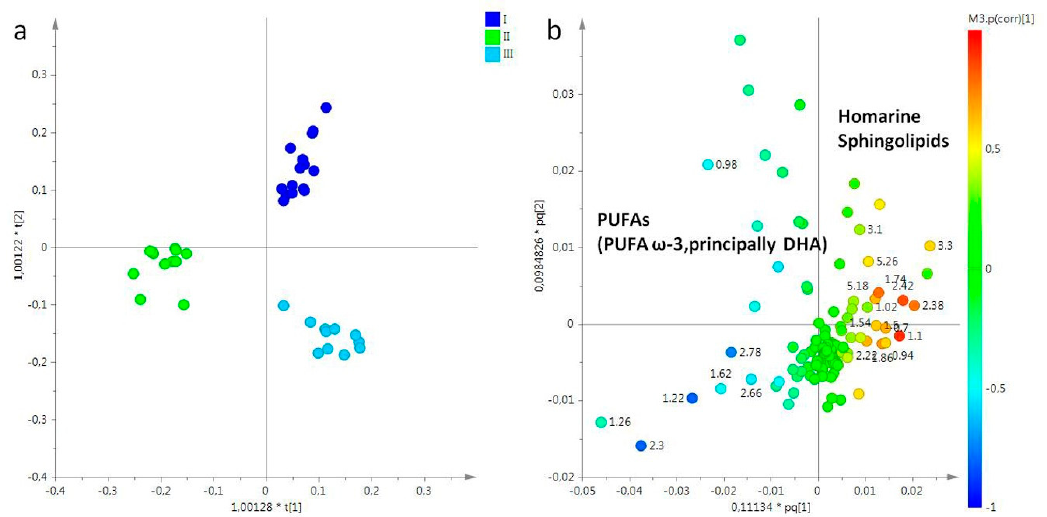
Figure 3. ( a ) OPLS-DA t[1] / t[2] scores plot of for lipid extracts of female gonads of R. pulmo collected in different sampling periods: blue circle, March sampling (I); green circle, May sampling (II); sky blue circle, July sampling (III). ( b ) Loading plot for the model; the variables indicated ppm in the 1 H NMR spectrum.